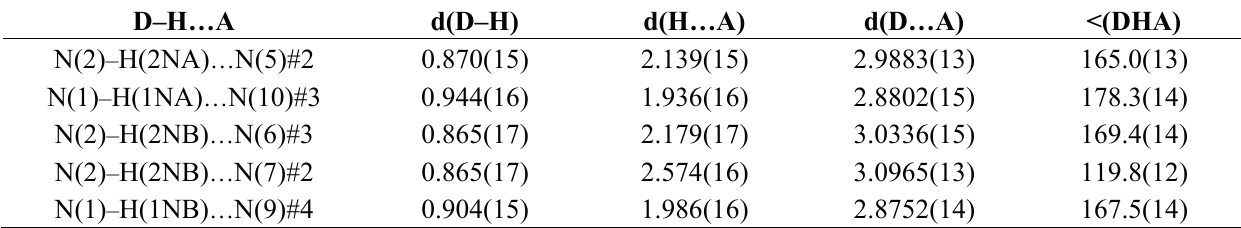
Figure 9. N–H…N hydrogen bonding in the crystal structure of 1 H -1,2,4-triazole-1- carboxamidine-5,5'-azotetrazolate ( 2 ). Table 3. Hydrogen bond lenghts [Å] in 2